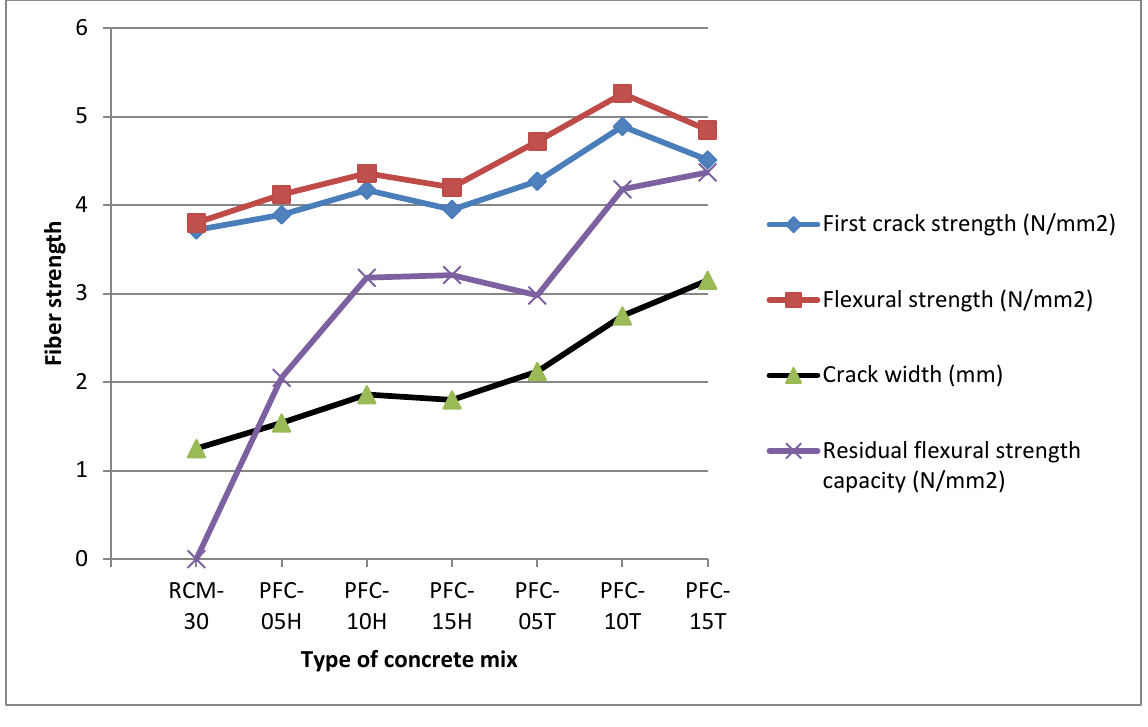
Figure 14. Variation of flexural strength parameters for various plastic fiber concrete mixes.